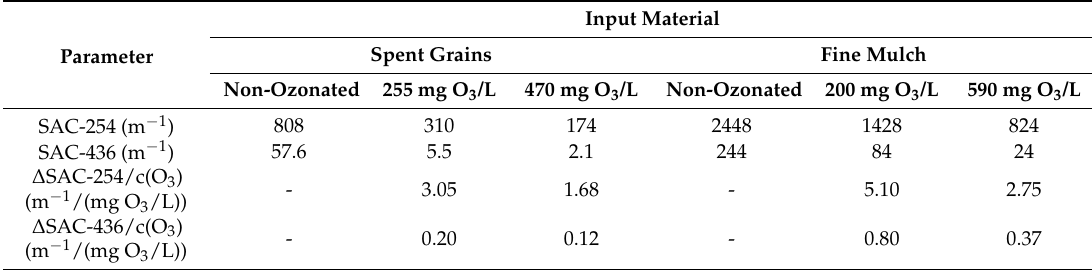
Table 5. Effect of ozonation on spectral absorption coefficients of pre-treated spent grains and fine mulch